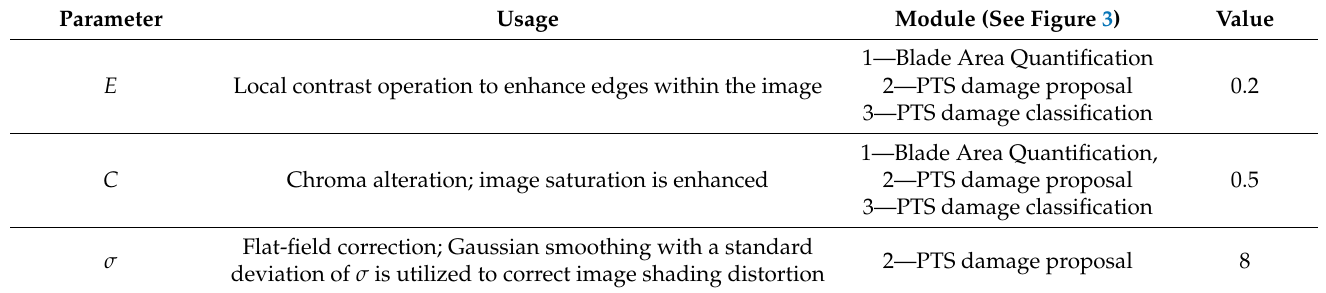
Table 1. Image preprocessing parameters used in the MATLAB (R2021a) image toolbox (Matlab functions utilized are imflatfield ( σ ) , localcontrast ( E ); saturation is enhanced via augmenting the saturation values in the hsv colorspace by a value of C ). These preprocessing steps are found to enhance unsupervised model accuracy and are optimized for application to field images of wind turbine blades. The parameters may be adjusted and optimized for other automated LEE quantification applications, such as for use in a whirling arm